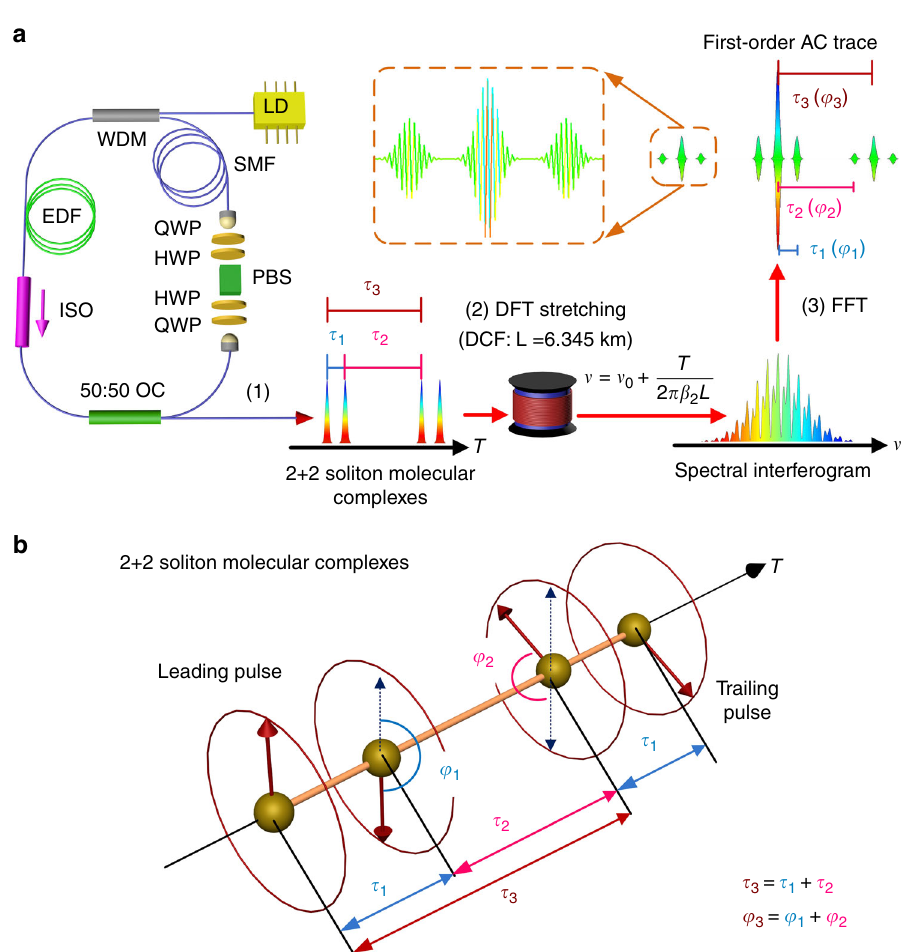
Fig. 1 Schematic of the generation and real-time characterisation of a soliton molecular complex. a A complex of two ultrafast soliton-pair molecules emitted from the fi bre ring laser (1) is characterised by the relative temporal separations τ i = 1,2,3 and phases φ i = 1,2,3 . To measure these internal degrees of freedom in real time by use of the dispersive Fourier-transform (DFT) method, the molecular complex is attenuated so as to propagate linearly (2) through a long length L of highly-dispersive optical fi bre (DCF, dispersion β 2 ). The temporal overlap between the pulses dispersed in the far- fi eld regime results in an interferogram, through the relationship between local time T and frequency v . The interferogram contains the information about the relative phases and temporal separations, which is revealed by fast Fourier-transforming (FFT) successive interferograms (3) on a shot-to-shot basis, yielding fi rst-order autocorrelation (AC) traces. As a result, we access the ultrafast evolution of the soliton molecular complex with a frame rate of tens of MHz – the cavity free spectral range. EDF erbium-doped fi bre, WDM wavelength-division multiplexer, LD laser diode, SMF single mode fi bre, PBS polarising beam splitter, ISO optical isolator, OC optical coupler, QWP quarter-wave plate, HWP half-wave plate. See Methods for laser cavity description. b Graphical representation of the internal degrees of freedom of a soliton molecular complex. The solitons are represented by phasors, distributed along a temporal axis according to their relative temporal separations τ i . The leading soliton is a fi xed phasor, pointing upward in the diagram, which serves as a reference for the succeeding phasors. This allows a clear representation of the internal dynamics of the soliton molecular